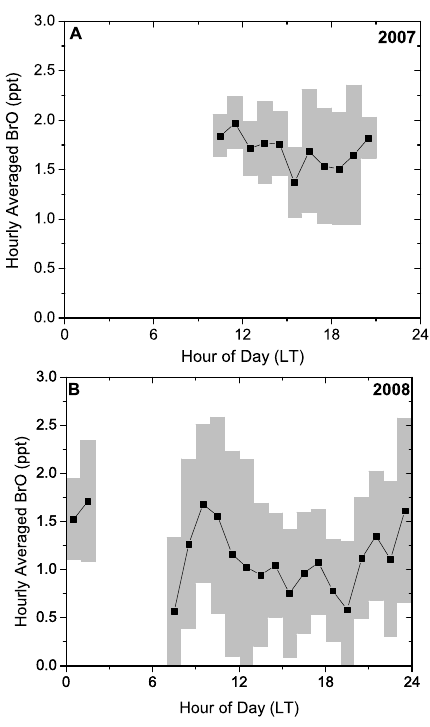
Fig. 6. Hourly averaged BrO mixing ratios for time periods with local airmasses in 2007 (A) and 2008 (B) . Please note that time is given in local